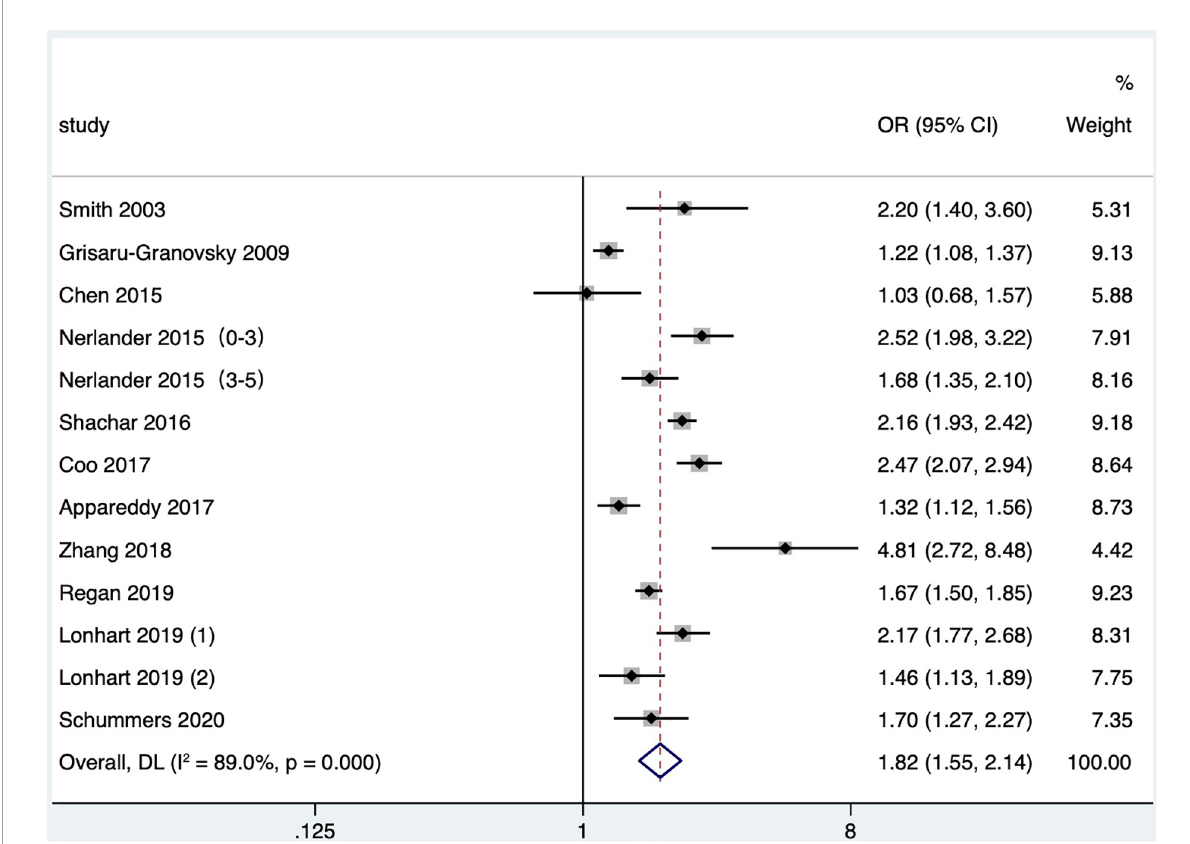
FIGURE3 Meta-analysis forest map of the effect of short IPI on very preterm birth. Nerlander et al. (27) (0–3) referred to the IPI of 0–3 months vs. 18–23 months; Nerlander et al. (27) (3–5) referred to the IPI of 3–5 months vs. 18–23 months; Lonhart et al. (43) (1) was non-Hispanic whites data, and Lonhart et al. (43) (2) was non-Hispanic blacks